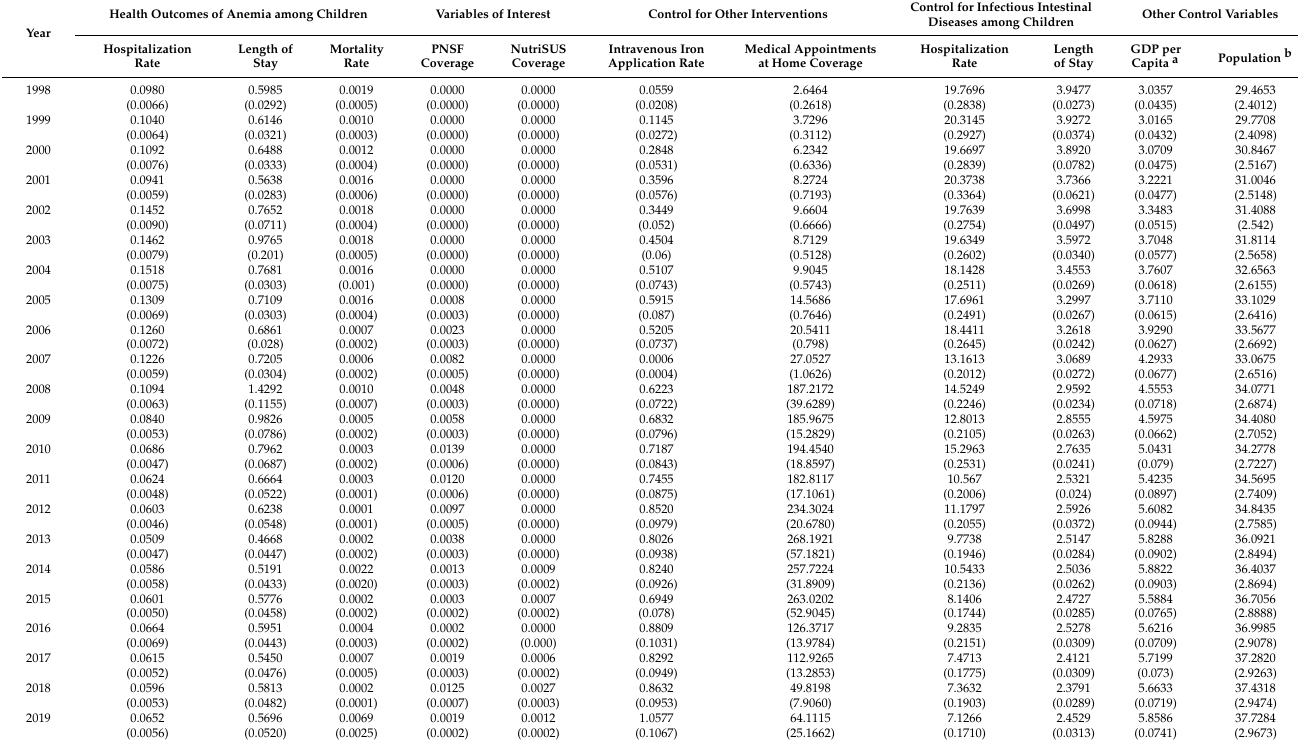
Table 2. Characteristics of the population (mean and standard errors), Brazil, 1998–2019.